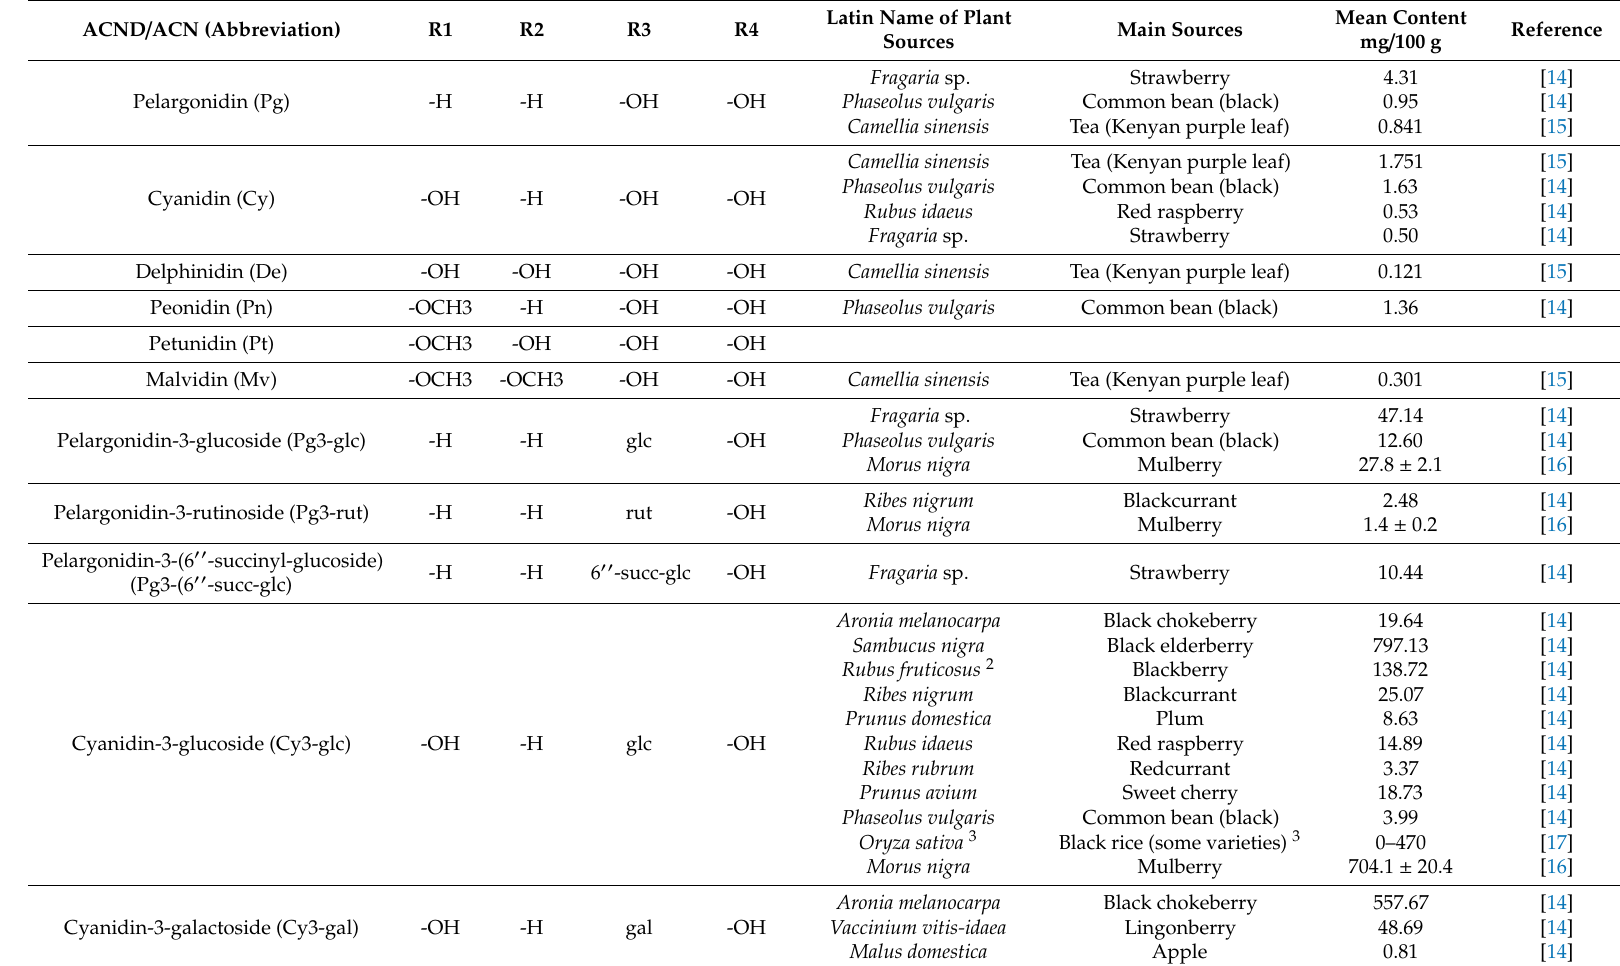
Table 1. The main anthocyanidins (ACND) and anthocyanins (ACN) from the human diet and the richest